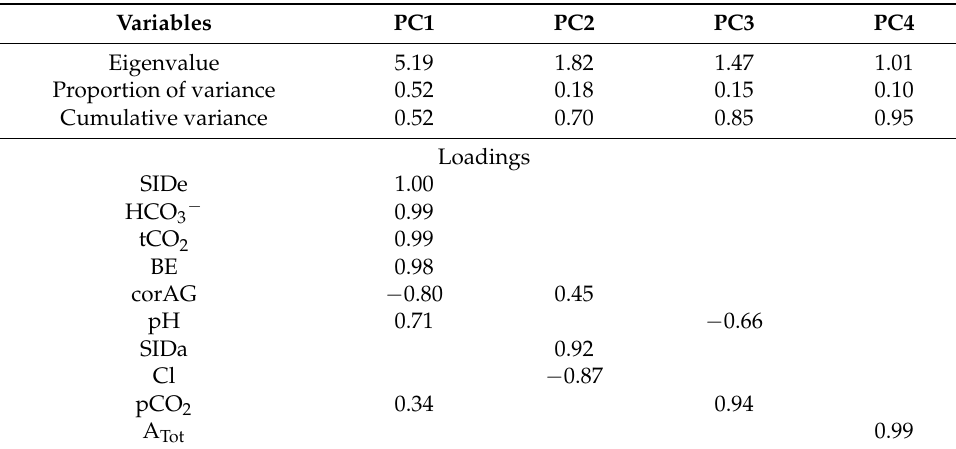
Table 4. Results of principal component analysis.